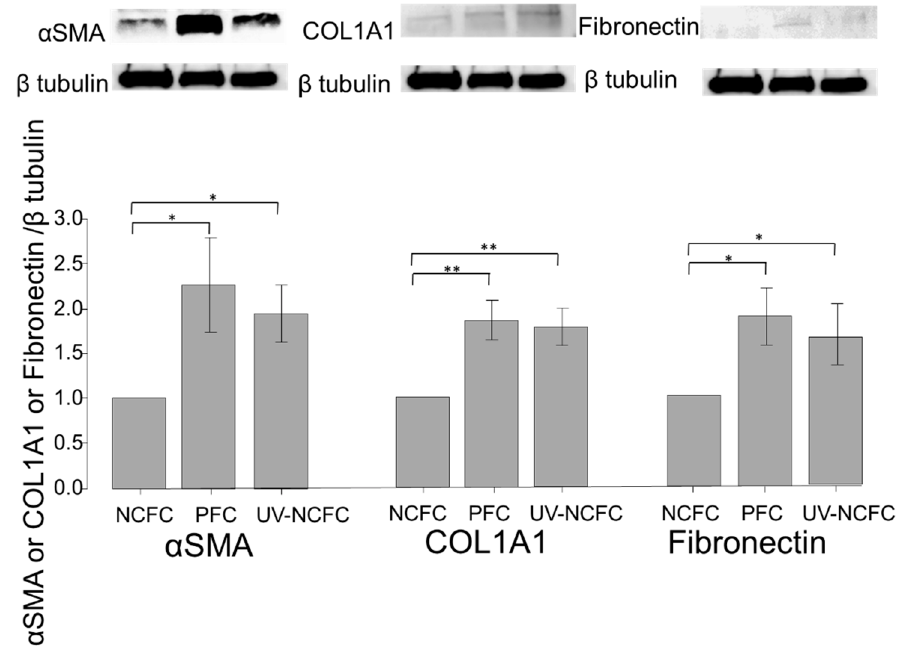
Figure 11. Western blotting of fibronectin, COL1A1, and α -SMA in NCFCs, PFCs, and UV-NCFCs ( n = 3). Relative expression of α -SMA, COL1A1, and fibronectin. Results are expressed relative to the loading control ( β -tubulin). These components were upregulated in PFCs and UV-NCFCs compared to NCFC. * p < 0.05, ** p < 0.01.